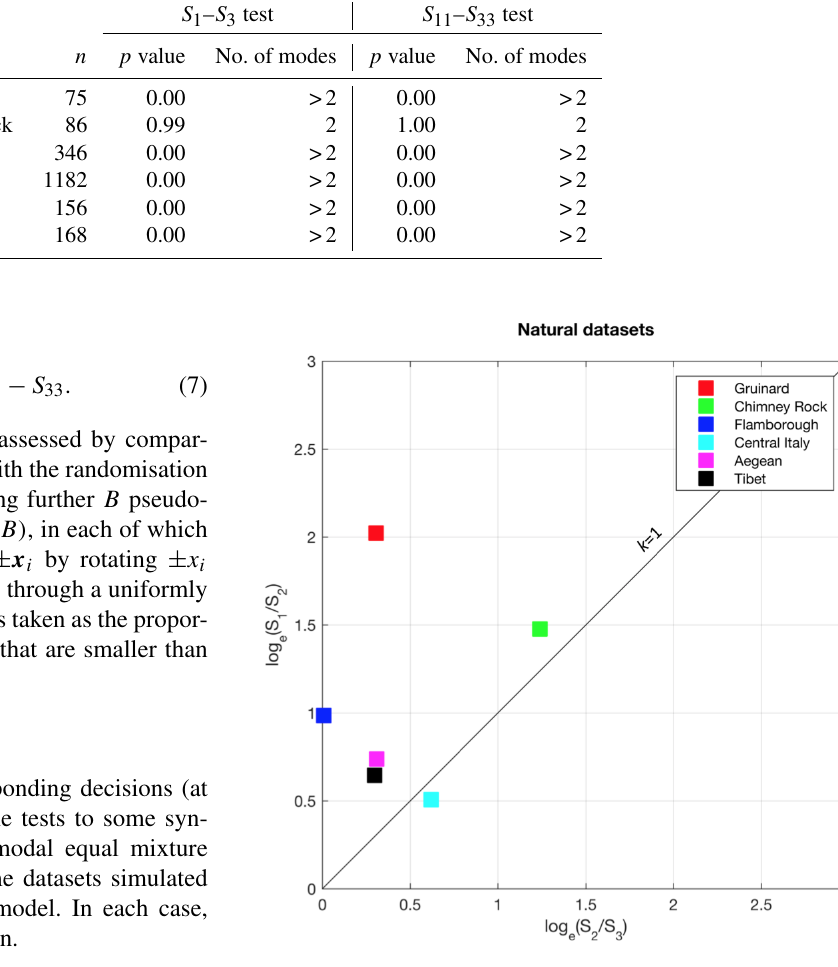
Figure 7. Eigenvalue ratio plot for the natural datasets shown in Fig. 5. All but one dataset (central Italy) lie above the line for k = 1. The best-constrained quadrimodal fault dataset (Gruinard) has the highest ratio of log e (S 1 /S 2 )